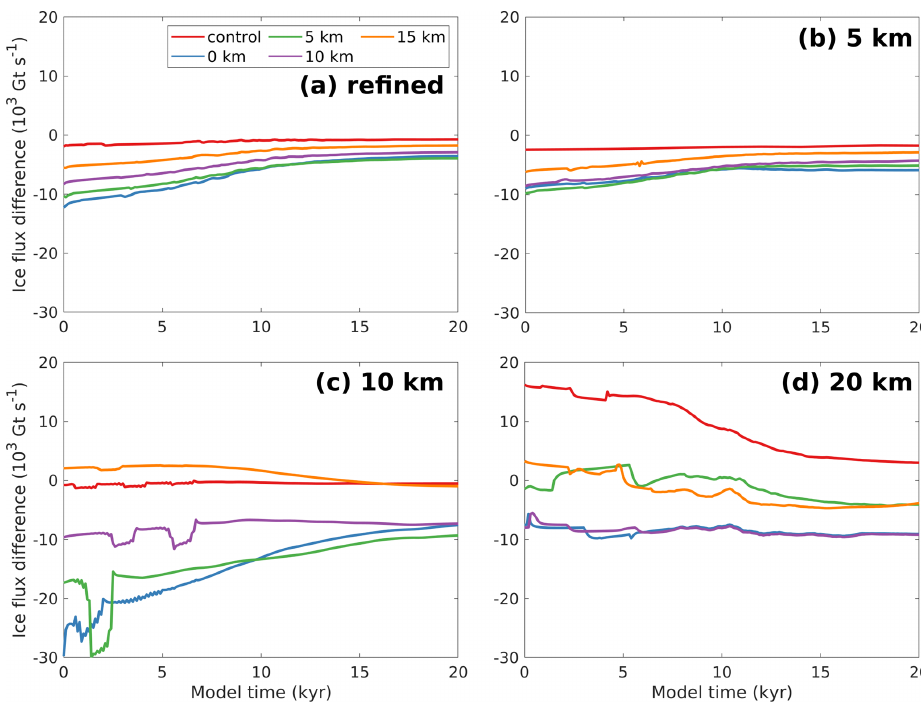
Figure 11. Difference between ice flux (in Gts − 1 ) 20km downstream and upstream of the nunatak summit (i.e. solid minus dashed lines in Fig. 8) over the entire simulation time for the experiments using a refined mesh (a) and regular meshes of a 5km (b) , 10km (c) , and 20km (d) horizontal resolution. This figure shows how the glacier width impacts ice advection downstream of the nunataks over time for all different model